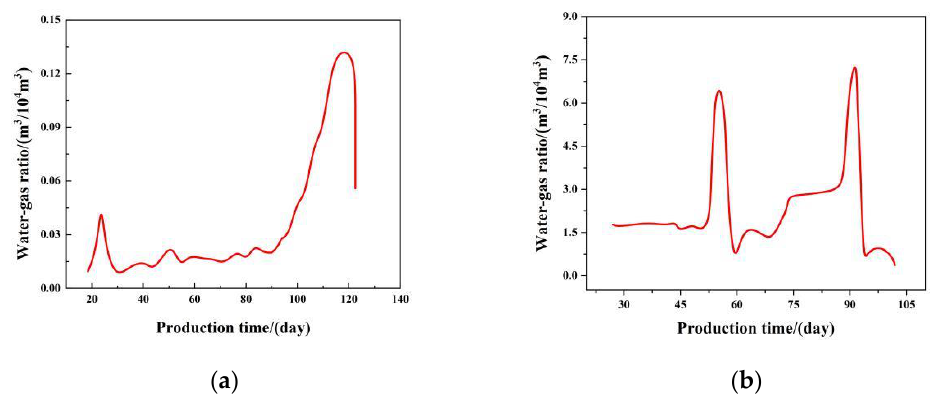
Figure 2. Production time vs. dynamic water–gas ratio curves for the CX-2 and CX-8 wells. ( a ) CX-2 gas well. ( b ) CX-8 gas well.